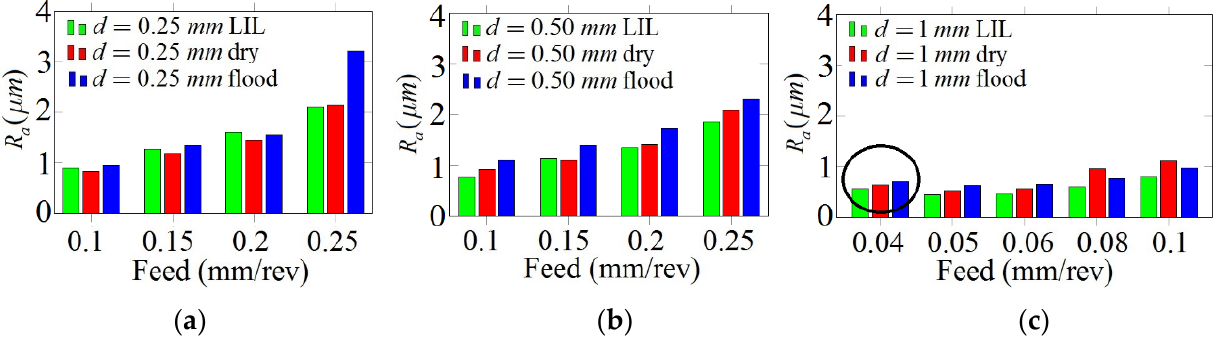
Figure 14. R a evolution for different depths of cut: ( a ) 0.25 mm, ( b ) 0.50 mm and ( c ) 1 mm.